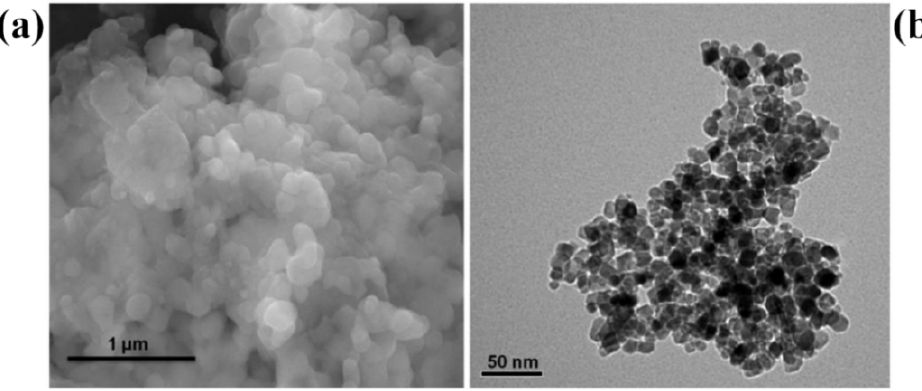
Figure 15. Green synthesis of TF-TiO 2 NPs: ( a ) HR-SEM and ( b ) HR-TEM. Reprinted from [59].